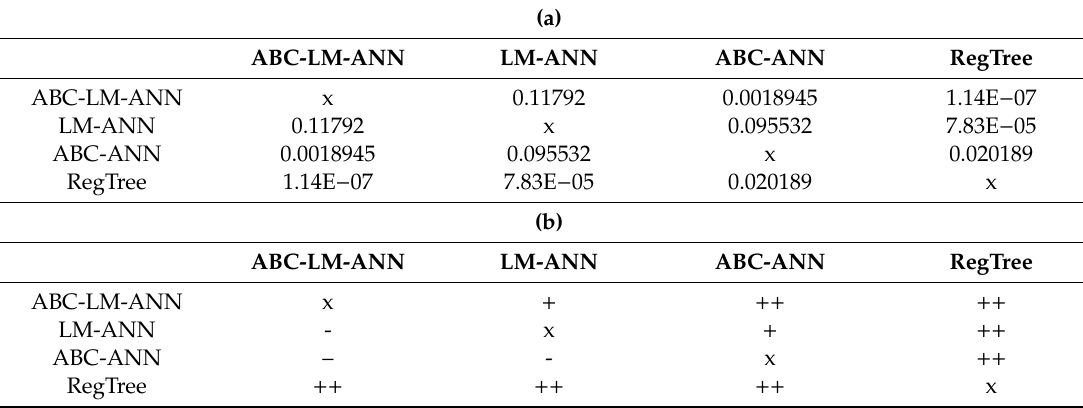
Table 5. The t -test results which compare the models’ performances in terms of R 2 : ( a ) p -values and ( b ) model pairwise comparison. Note: “ ++ ”, “ + ”, “–”, and “-” denote a significant win, a win, a significant loss, and a loss,